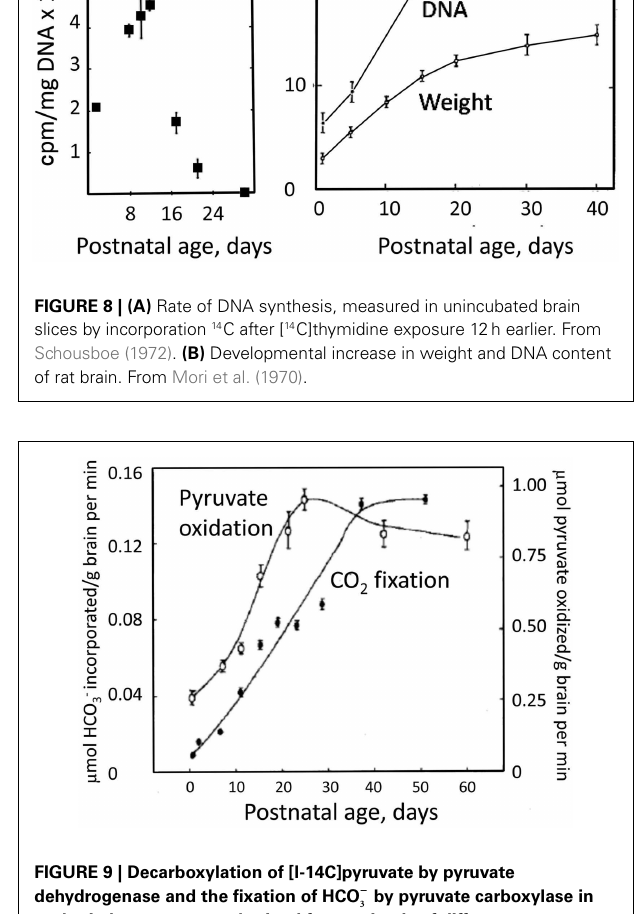
uptakeinculturedastrocytes,whichisquitepronounced,although